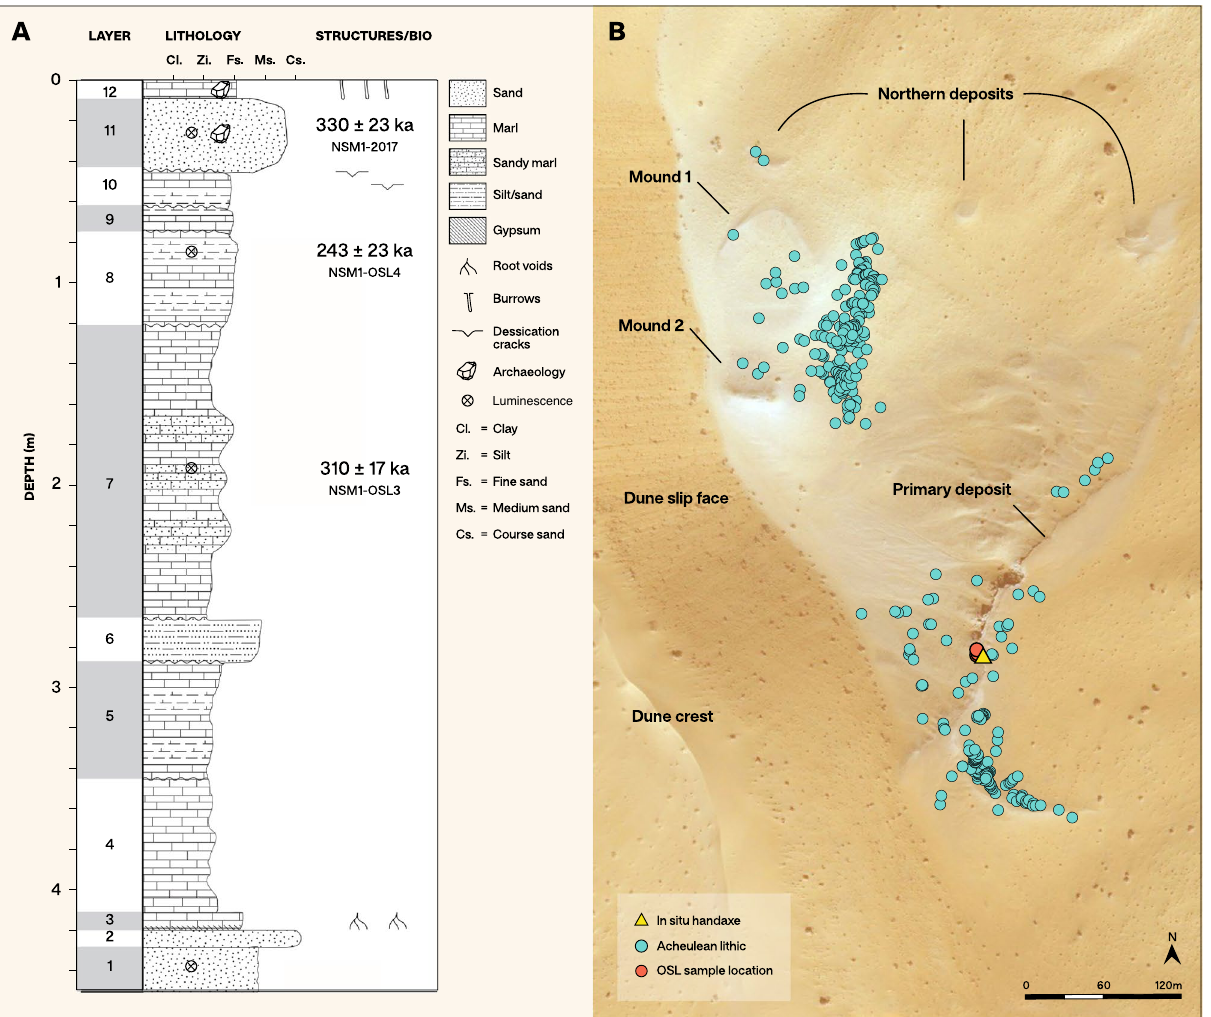
Figure 2. Stratigraphic sequence of An Nasim and artefact distributions. ( a ) stratigraphy with the locations of the sediment samples dated by luminescence; ( b ) Lower Palaeolithic artefacts at An Nasim, mapped through systematic survey of the current interdune and recorded using a differential GPS system. The stratigraphic sequence was drawn from the location of the handaxe in Layer 12. Produced using ArcMap version 10.2. Basemap from Bing Maps Aerial, ( c ) 2010 Microsoft Corporation and its data